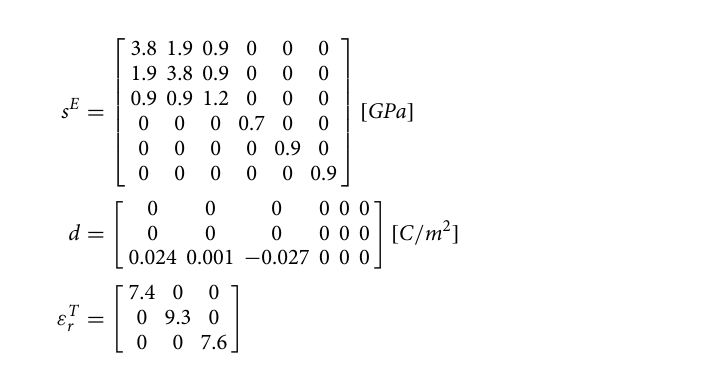
Figure 5. ( a ) Generated power and voltage in bare case, and generated ( b ) voltage, ( c ) power, and ( d ) current in working